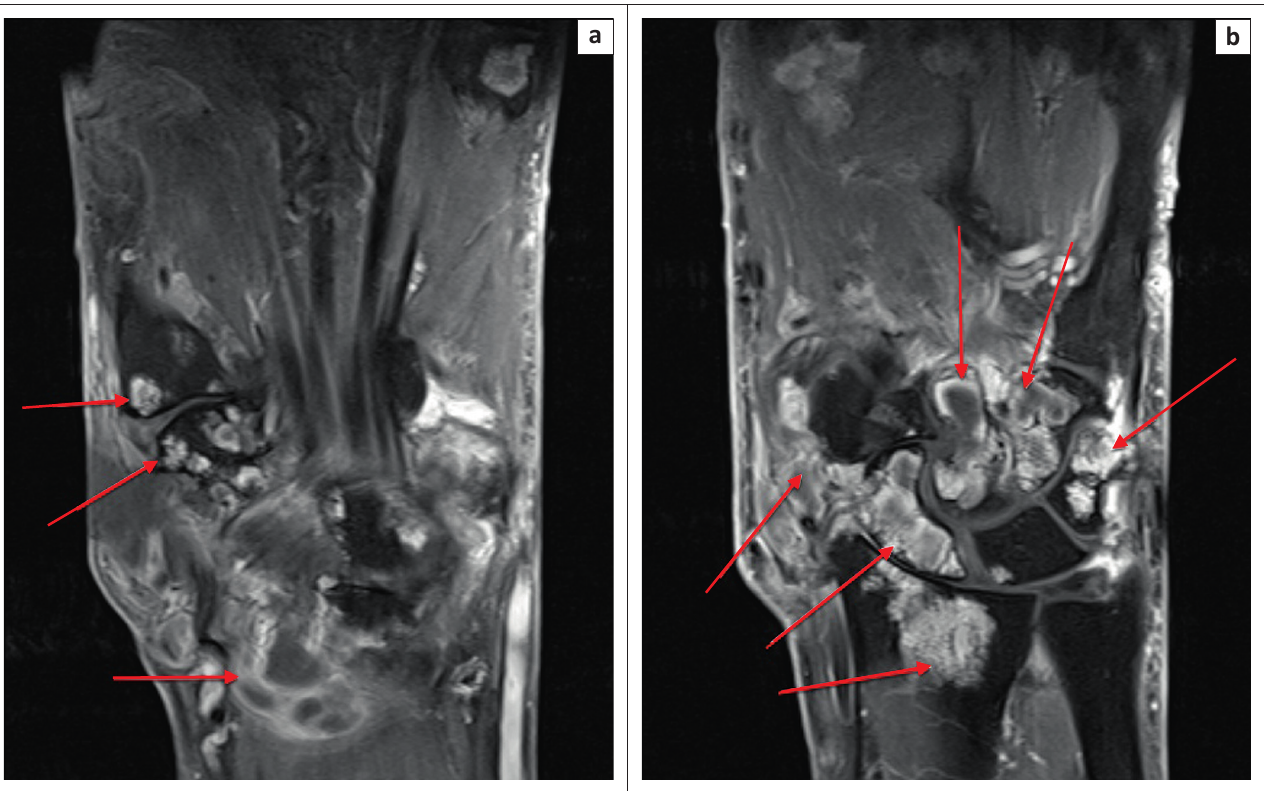
FIGURE 5: Coronal T1-weighted post intravenous gadolinium images (a and b). Intense, predominantly peripheral enhancement of the thenar mass and osseous erosions (red